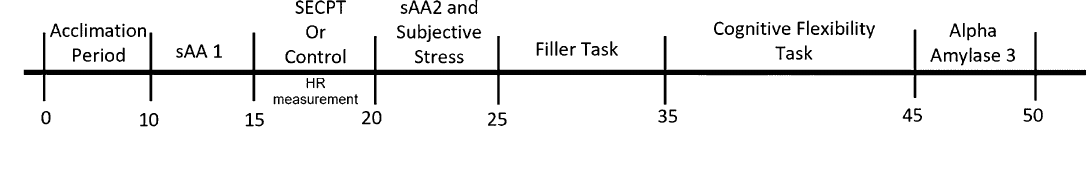
Figure 3. Schematic of experimental procedure timeline for Day 2; sAA salivary alpha amylase, SECPT socially evaluated cold pressor